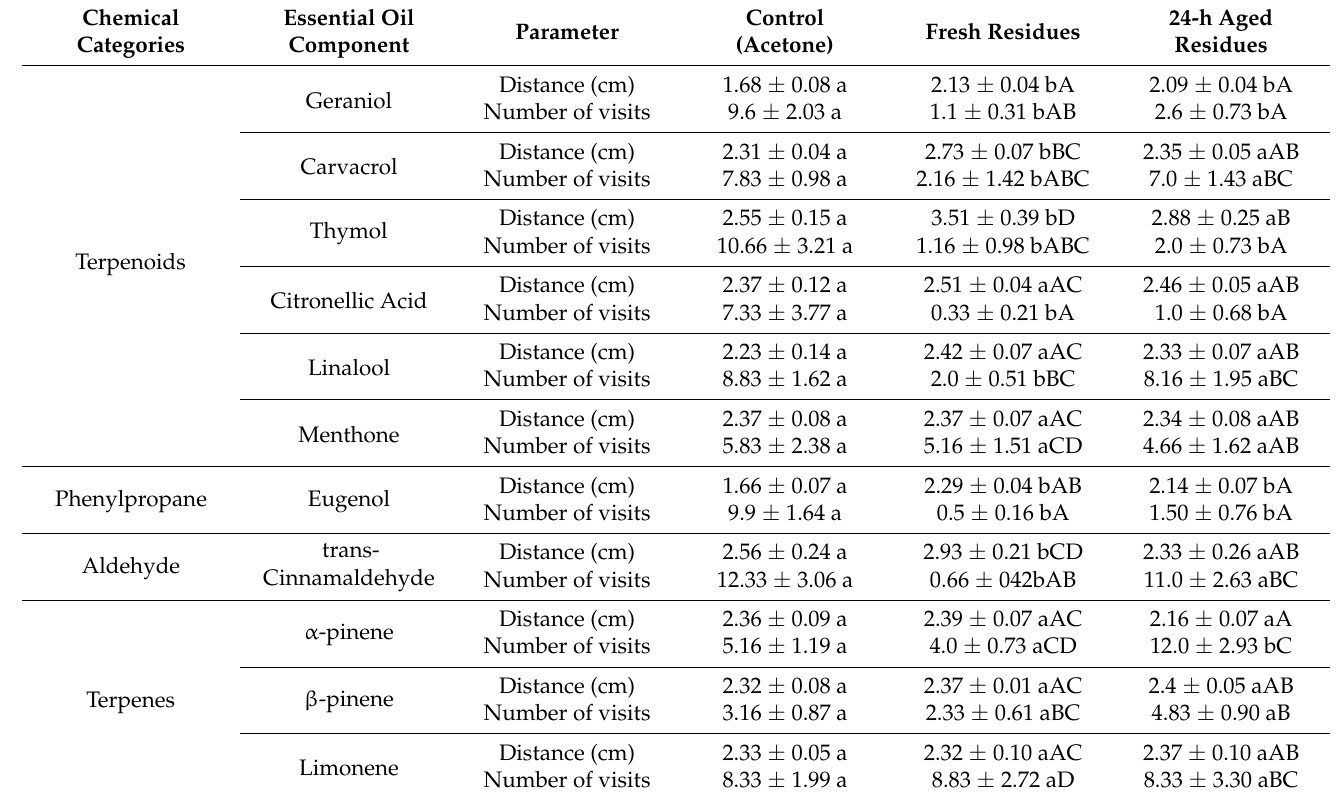
Lower case letters are for mean comparison within each treatment (rows), while capital letters are for mean comparison among treatments